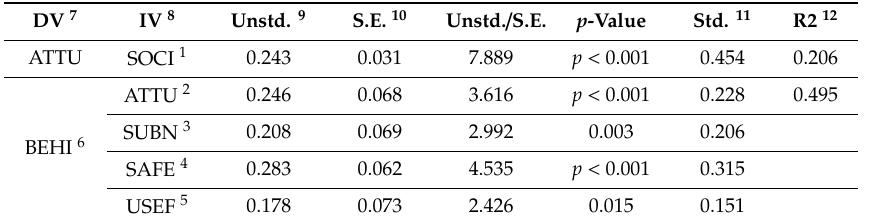
Table 7. Path analysis.